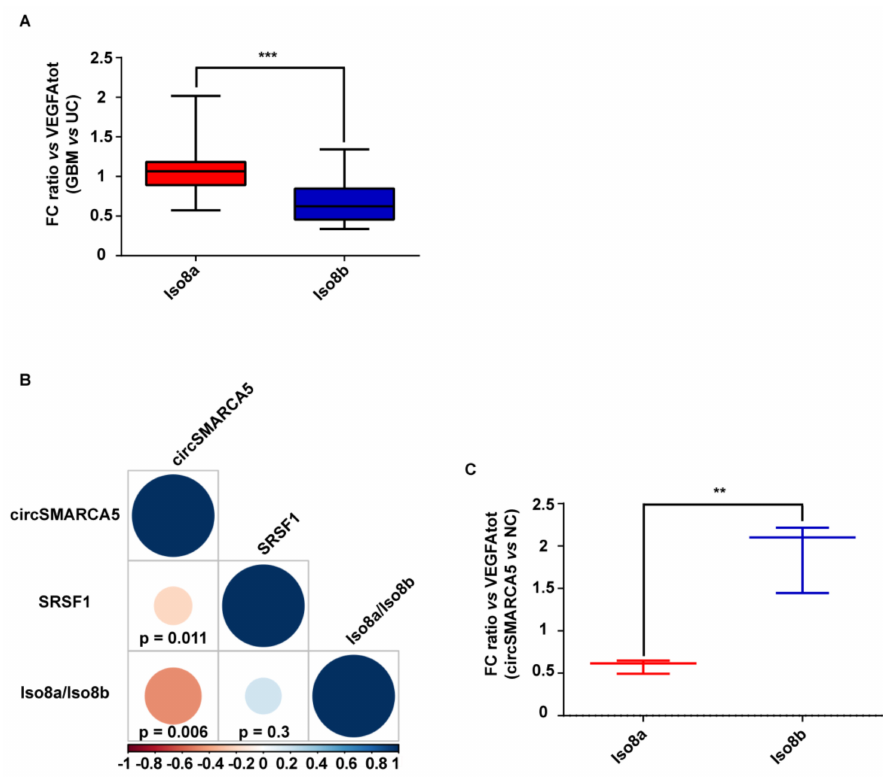
Figure 3. Iso8a-to-Iso8b ratio in GBM biopsies vs. UC. ( A ) Box-and-whisker plots, representing the ratios between fold changes of Iso8a and total VEGFA (VEGFA tot ) and Iso8b and VEGFA tot in GBM compared to UC (*** p -value < 0.00001, N = 27, Mann–Whitney test) (see Section 4 Materials and Methods for details on data analysis). ( B ) Correlation matrix among the expression of circSMARCA5 and SRSF1 and Iso8a-to-Iso8b ratio. Positive and negative correlations are displayed in blue and red colors, respectively. The color scale bar indicates r values. Color intensity and the size of the circle are proportional to the correlation coefficients into the correlogram. ( C ) Box-and-whisker plots, representing the ratios between fold changes of Iso8a and VEGFA tot and Iso8b and VEGFA tot in U87-MG overexpressing circSMARCA5 with respect to U87-MG transfected with the empty vector (NC) (** p -value < 0.001, N = 3, two-sample t -test) (see Section 4 Materials and Methods for details on data